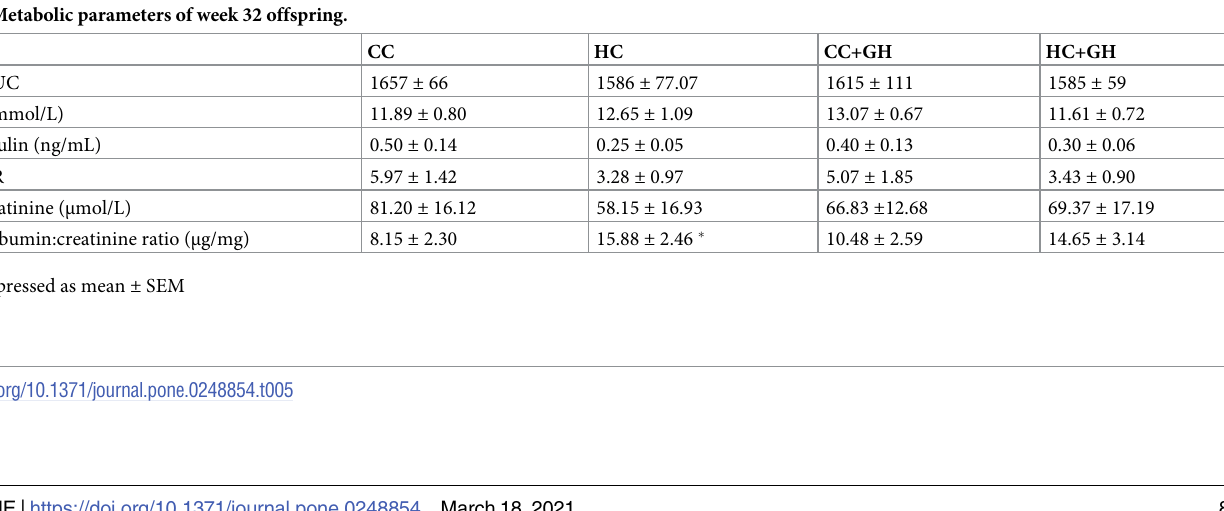
hydralazine (Table 4). By week 32, offspring of obese mothers had significantly increased albu- minuria compared to controls (p < 0.05, Table 5). Hydralazine administration during gestation did not significantly attenuate albuminuria in the offspring of obese mothers (Table 5).